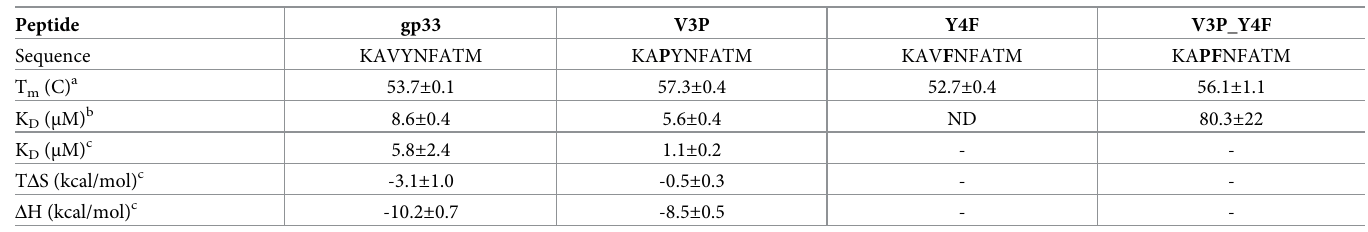
a Measured with Circular Dichroism where T b Determined from steady state SPR data with software BIAevaluation.